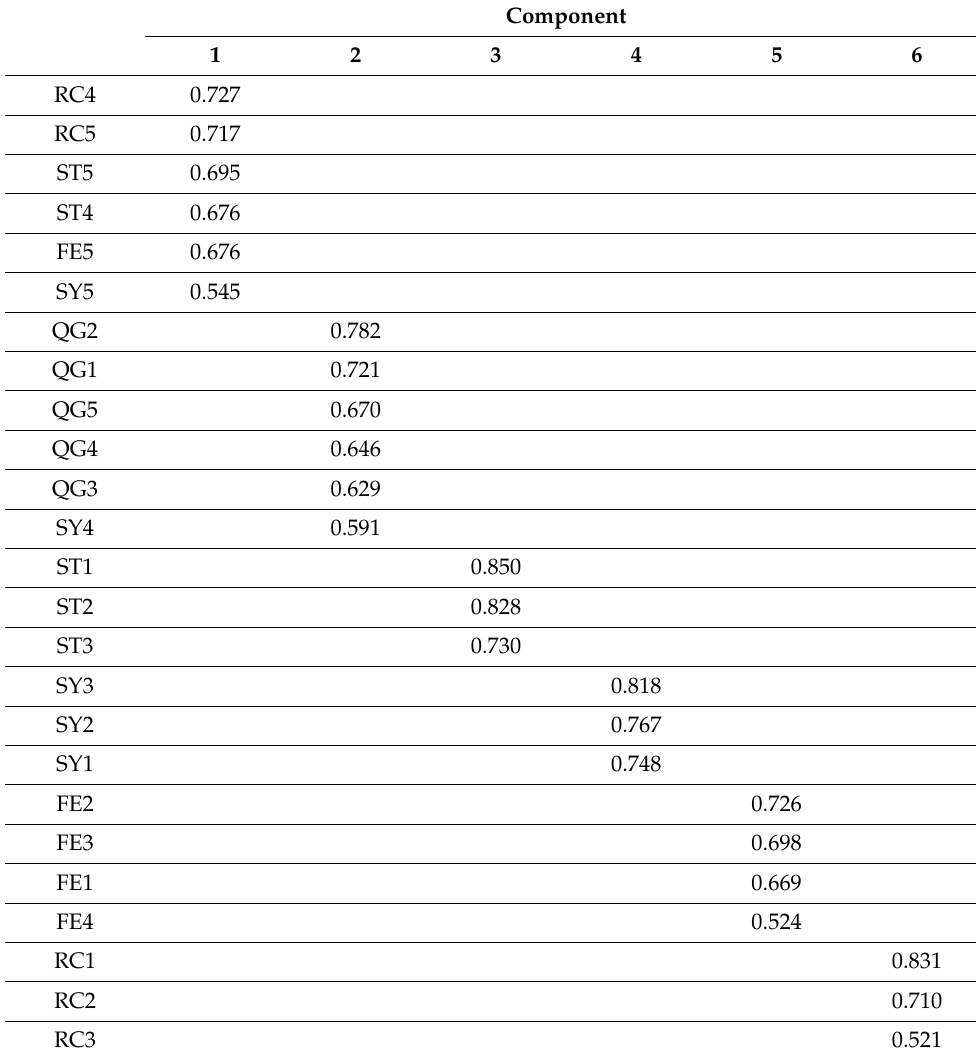
Table 5. Rotated Component Matrix.